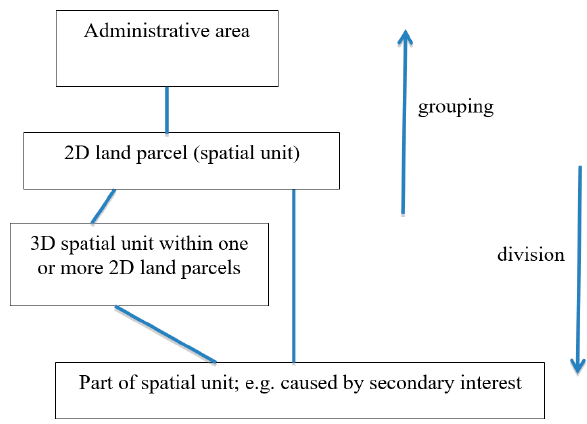
Figure 1. A rough “hierarchy” of spatial units.